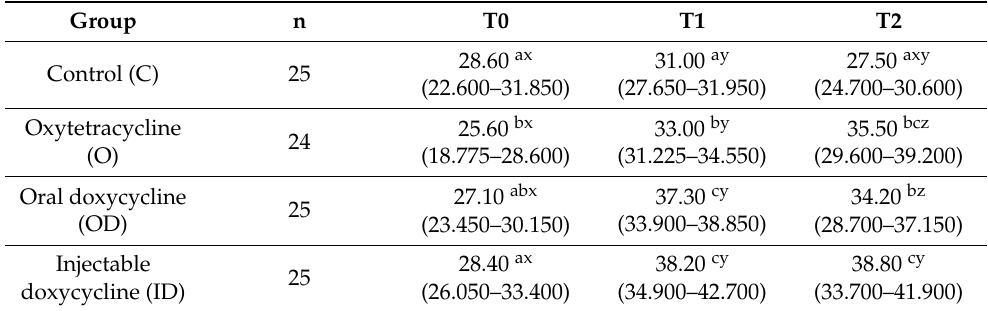
Table 3. Median (25th and 75th percentile values) haematocrit (%) of lambs that were treated with